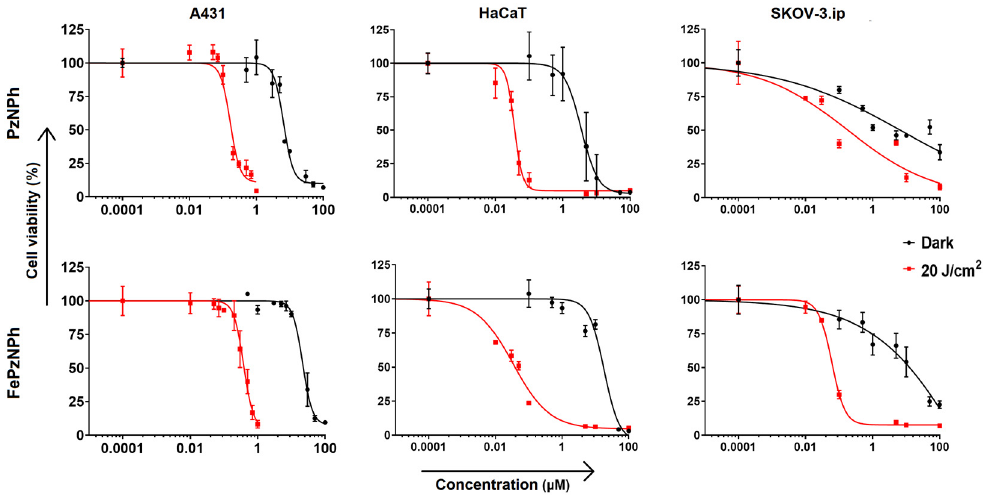
Figure 6. Dark toxicity and photodynamic activity of PzNPh and FePzNPh against human epidermoid carcinoma A431 cells, human keratinocytes HaCaT and human ovarian adenocarcinoma SKOV-3.ip cells. To induce a photodynamic response, the cells were irradiated with light at a dose of 20 J/cm 2 (615–635 nm, 20 mW/cm 2 ). The data are presented as the mean values ± SD ( n = 3). Data on cytotoxicity for PzNPh did not differ from those obtained previously [44]. Table 2. Dark toxicity and photodynamic activity of PzNPh and FePzNPh against A431, HaCaT, and SKOV-3.ip cells.